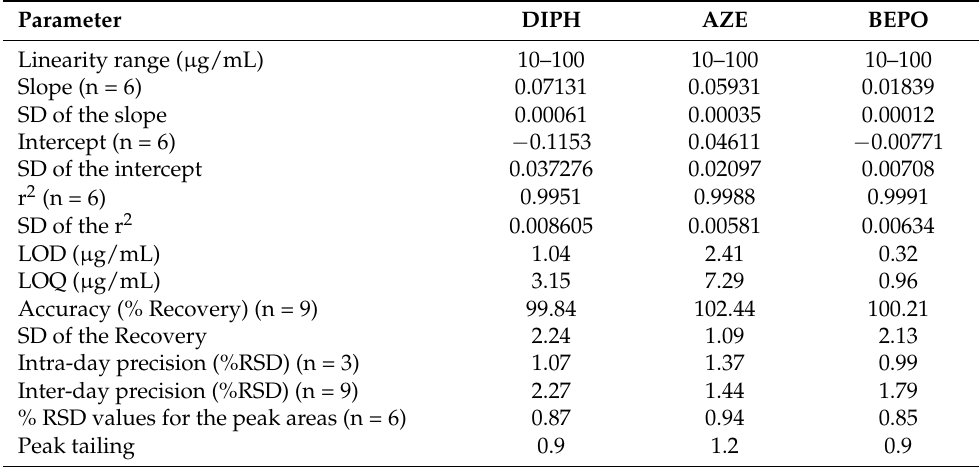
Table 1. Parameters of HPLC-UV methods for the quantitative determination of diphenhydramine (DIPH), azelastine (AZE) and bepotastine (BEPO). Parameter DIPH